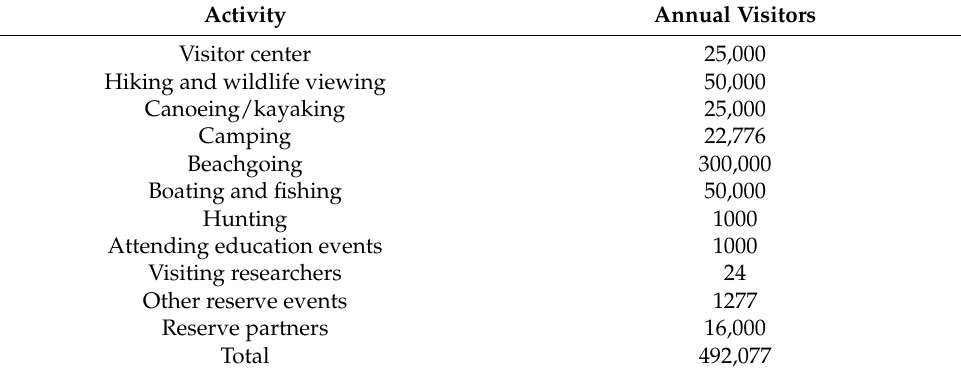
Table 9. Annual visitors to the Apalachicola Reserve by activity